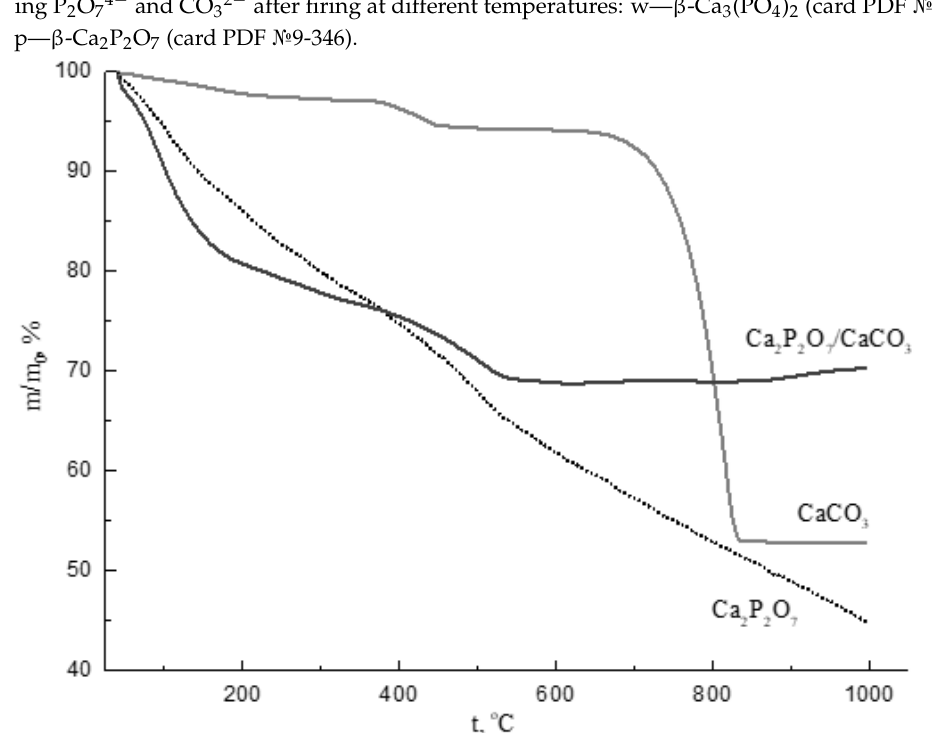
Figure 3. Thermal analysis (TG) data for powders synthesized from calcium acetate and ammonium pyrophosphate (CPP-curve); calcium acetate and ammonium carbonate (CC-curve); calcium acetate and mixed-anionic solution containing pyrophosphate and carbonate ions (CPP/CC-curve). Thermogravimetry curves obtained for the synthesized powders indicate that total mass losses for CC, CPP/CC, and CPP powders were 47, 55, and 30 wt %, respectively. The curve related to the CC sample (CaCO 3 ) reflects the decomposition processes of the by- product (CH 3 COONH 4 ) and target product (Equation (6)). CPP-curve (Ca 2 P 2 O 7 ) reflects the processes of probable by-product decomposition, dehydration of Ca 2 P 2 O 7 · xH 2 O, and its conversion to β -Ca 2 P 2 O 7 in accordance with the reaction (7). The curve for CPP/CC sample (Ca 2 P 2 O 7 /CaCO 3 ) reflects the continuous mass loss associated with both the processes